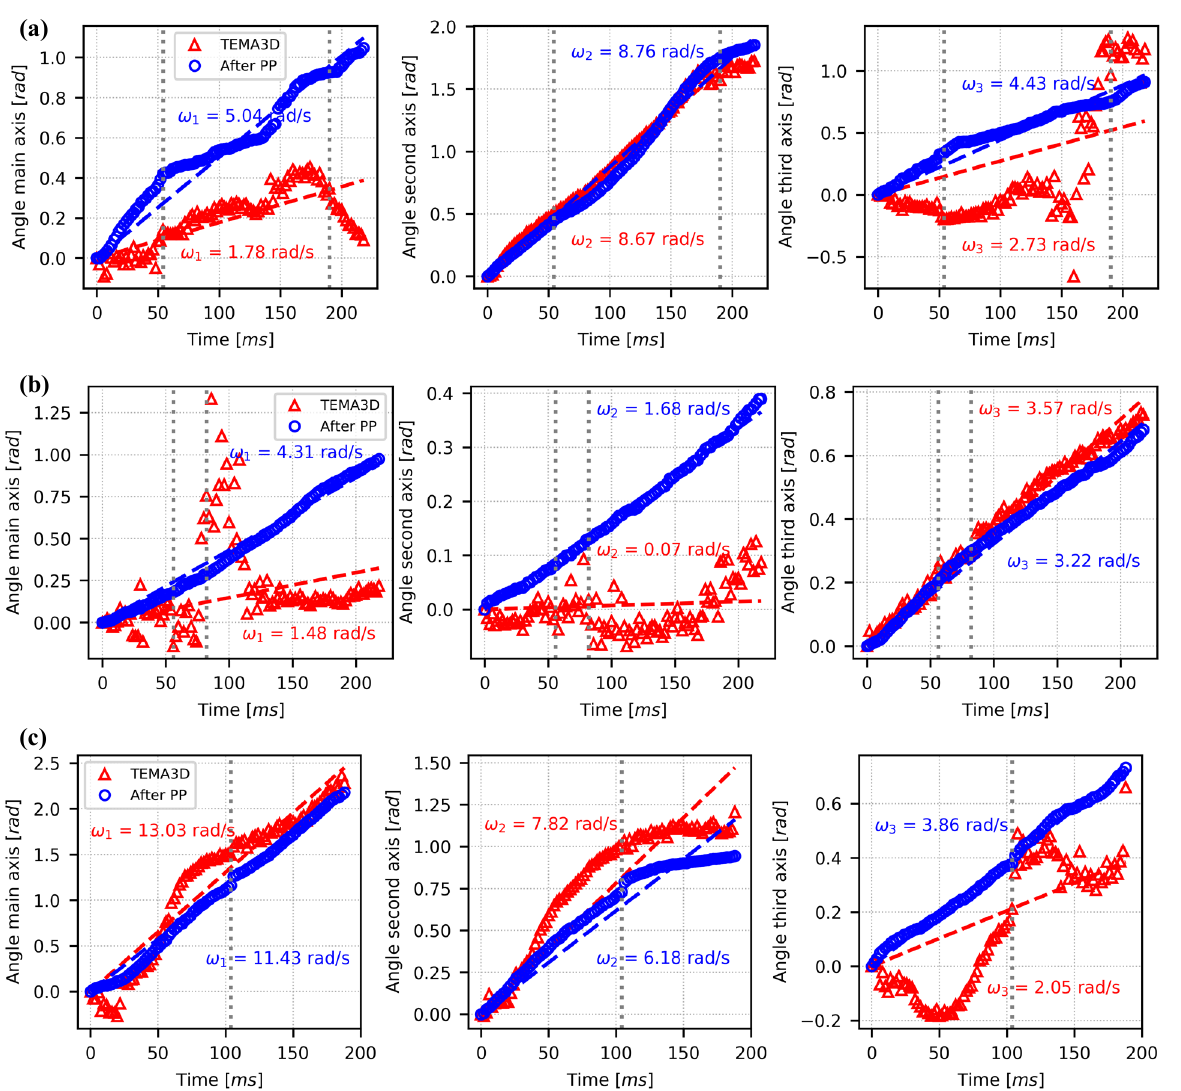
Figure 13. Cumulative rotation angles around the principal axes and corresponding estimate d rotational velocities (ω) for: (a) fragment F1, (b) fragment F2 and (c) fragment F3. Vertical dotted lines indicate change in number of views (see Table 5).